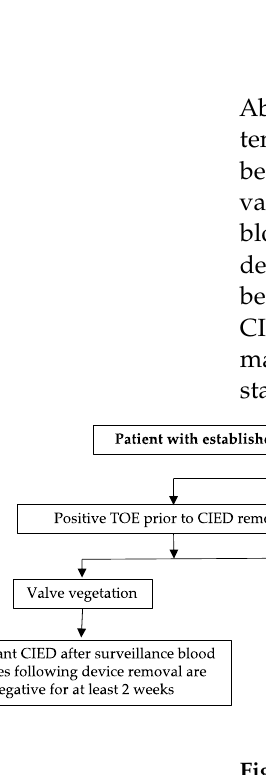
Table 2. Antibiotic treatment recommendation.